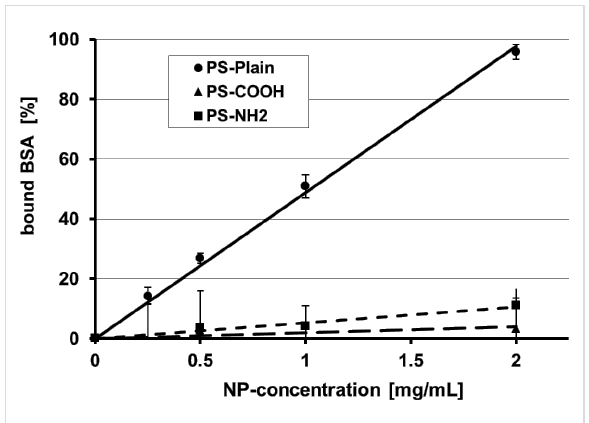
Figure 1: Bovine serum albumin (BSA) depletion in the supernatant after BSA separation from the 50 nm Polystyrene (PS) NP–protein complexes (PS-Plain: neutral charge, PS-COOH: negative charge by carboxyl groups, PS-NH 2 : positive charge by amino groups) depending on the NP dose; the error bars show the standard deviation). Each line represents the linear regression forced through the coordinate origin with the slope representing the binding index (BI). BSA binds with a much higher BI to hydrophobic, neutrally charged PS-Plain NP than the two other hydrophilic PS-NP. Reproduced with permission from [5]. Copyright 2011 Informa Plc.